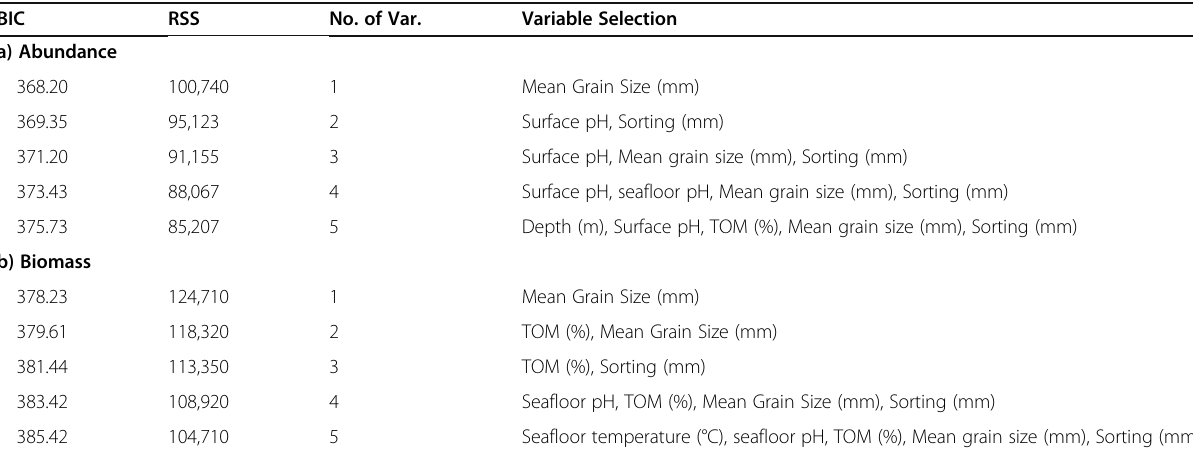
Table 6 Best group of variables selected by DISTLM analysis, utilizing the BEST procedure and Bayesian Information Criterion (BIC) for resemblance matrixes based on (a) abundance and (b) biomass. BIC = Bayesian Information Criterion and RSS = Residual Sum of Squares BIC RSS No. of